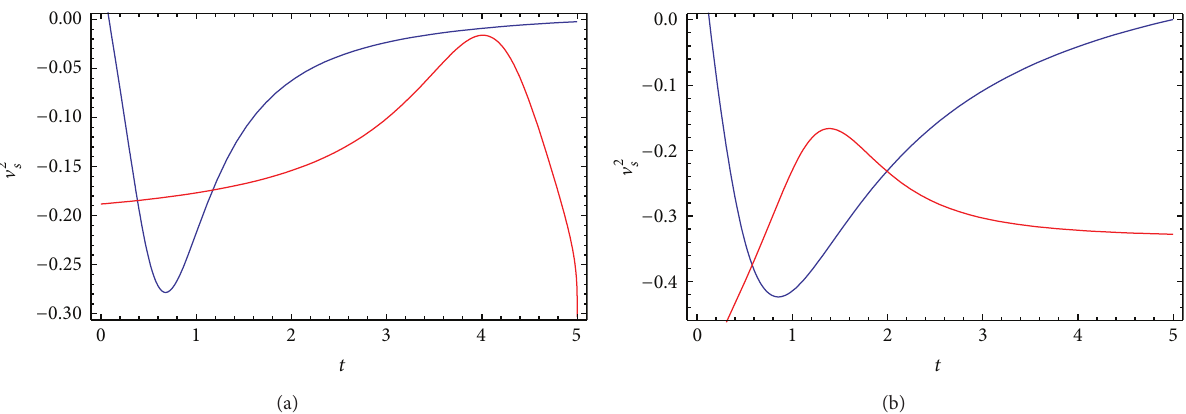
Figure 4: ((a) and (b)) The variations of V 2 𝑠 against 𝑡 for ECHDE and ECNADE models. Blue line represents type I model and red line represents type II